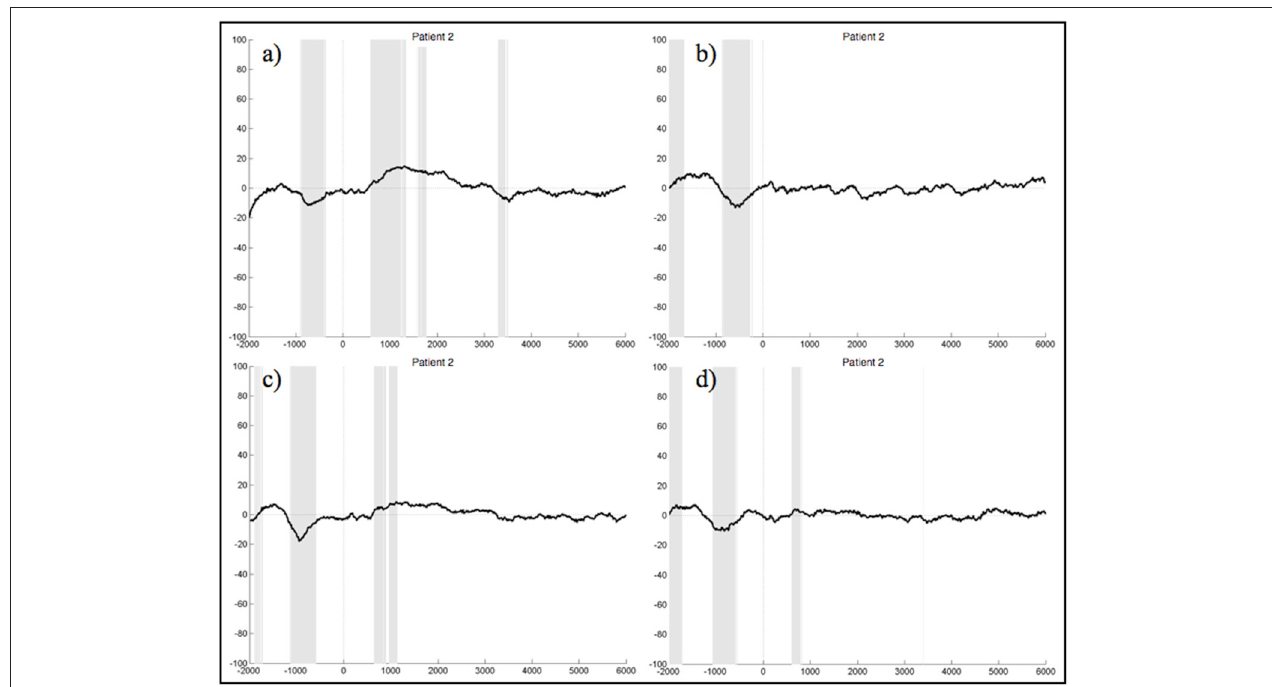
FIGURE 7 | Average ERPs of patient 2 recorded on the electrode Pz during the foot (a) and hand (c) movement execution conditions and during the imagination of foot (b) and hand (d) movements. Conditions start at time 0. Segments are not corrected for artifacts. The x-axis displays time (ms) and the y-axis amplitudes ( µ V). Gray shading indicates significant differences from the resting condition on a single trial level with p <